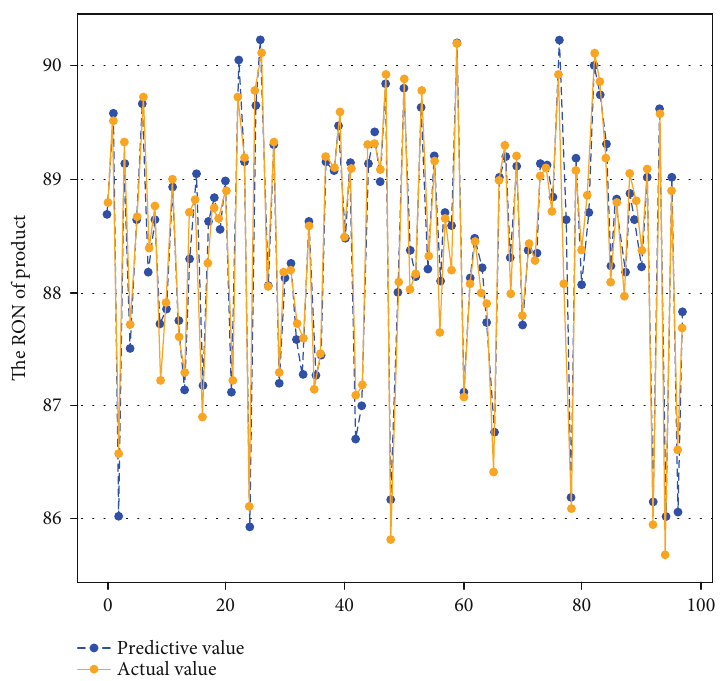
Figure 4: Fitting fi gure random forest variable random forest